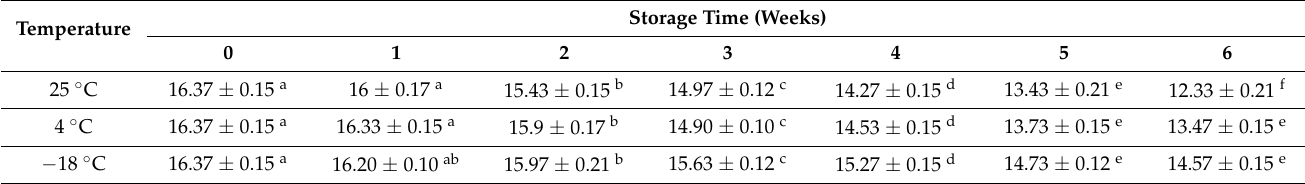
Table 2. Swelling ratio of SPI edible films stored at different temperatures (25 ◦ C, 4 ◦ C, and − 18 ◦ C). Temperature